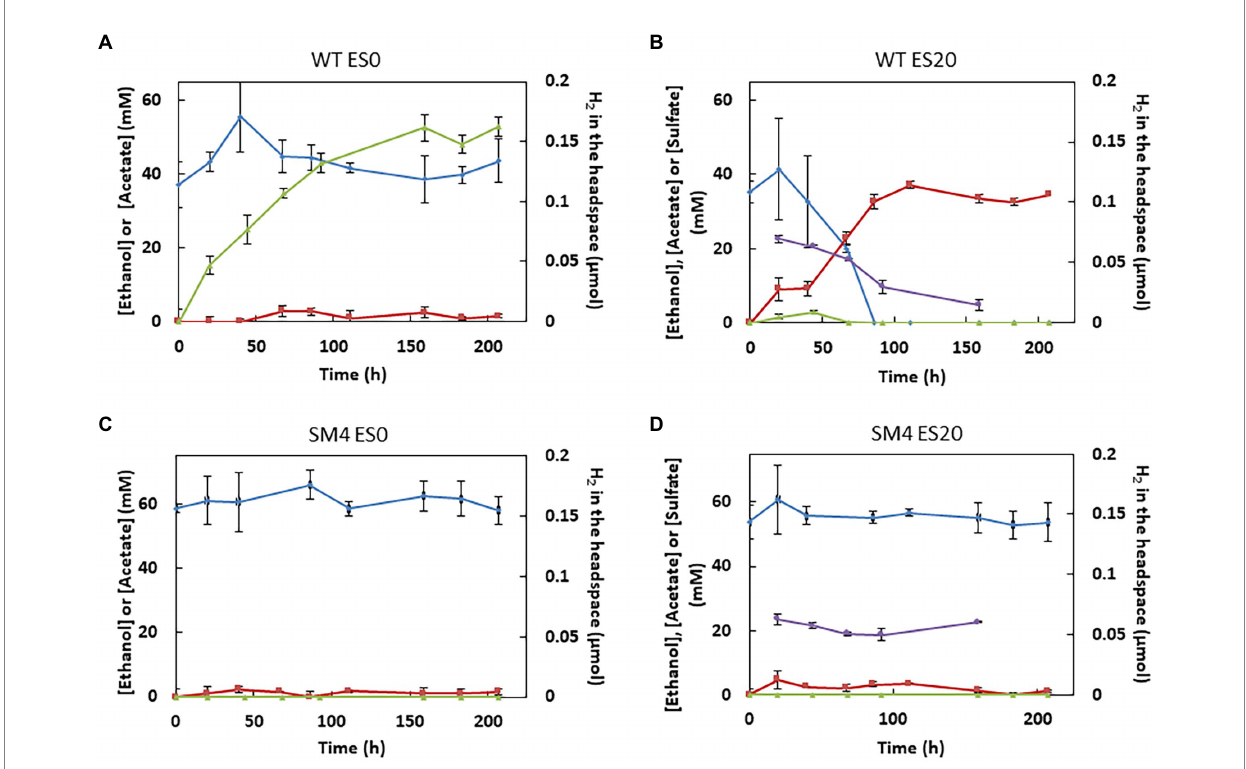
FIGURE 2 Acetate, ethanol, sulfate, and H 2 quantification. Acetate (red curves), ethanol (blue curves), and sulfate (purple curves) in the growth medium and H 2 in the headspace (green curves) were quantified by HPLC, ionic chromatography or GC during the growth of the S. fructosivorans WT strain (A,B) or the SM4 mutant strain (C,D) in the ES0 medium (A,C) or the ES20 medium (B,D) . Analyses were performed on the same S. fructosivorans cultures as those used for the growth curves. Data represent the averages of the results of three replicate growths. Error bars correspond to standard